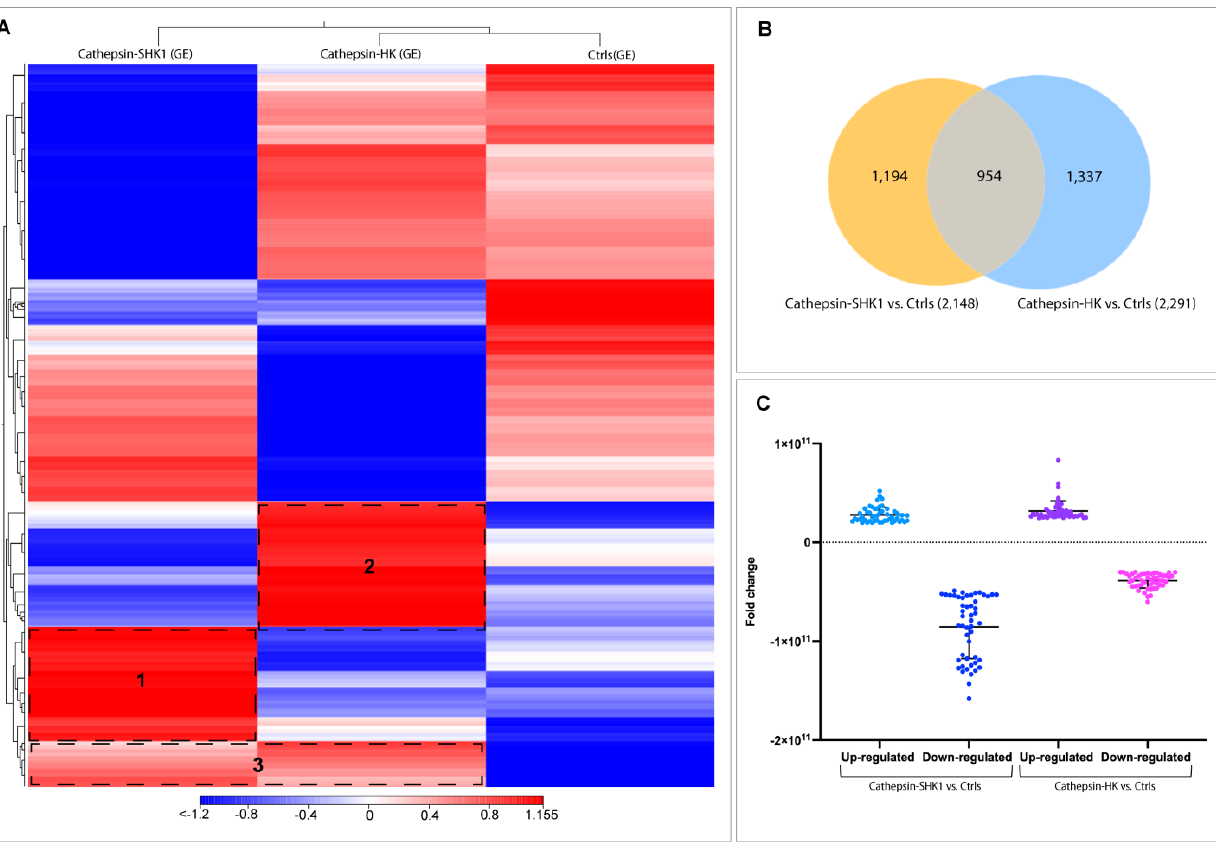
Figure 5. Transcriptome profiling of lncRNA from the SHK-1 cell line and salmon HK exposed to recombinant Cr-cathepsin. ( A ) Heatmaps for each treatment were constructed with the TPM (transcripts per million of reads) values of lncRNAs and grouped by hierarchical clustering based on Manhattan distance with average linkages. A red color indicates up-regulated lncRNAs, and blue represents down-regulated transcripts. ( B ) A Venn diagram representing the significantly expressed lncRNA among tissues (SHK-1 cell line and salmon HK exposed to Cr-cathepsin) vs. control group (|fold change| > 4, p -value < 0.05). ( C ) LncRNA fold-change variation up/down-regulated in SHK-1 cell line and salmon HK exposed to Cr-cathepsin vs. the control group.